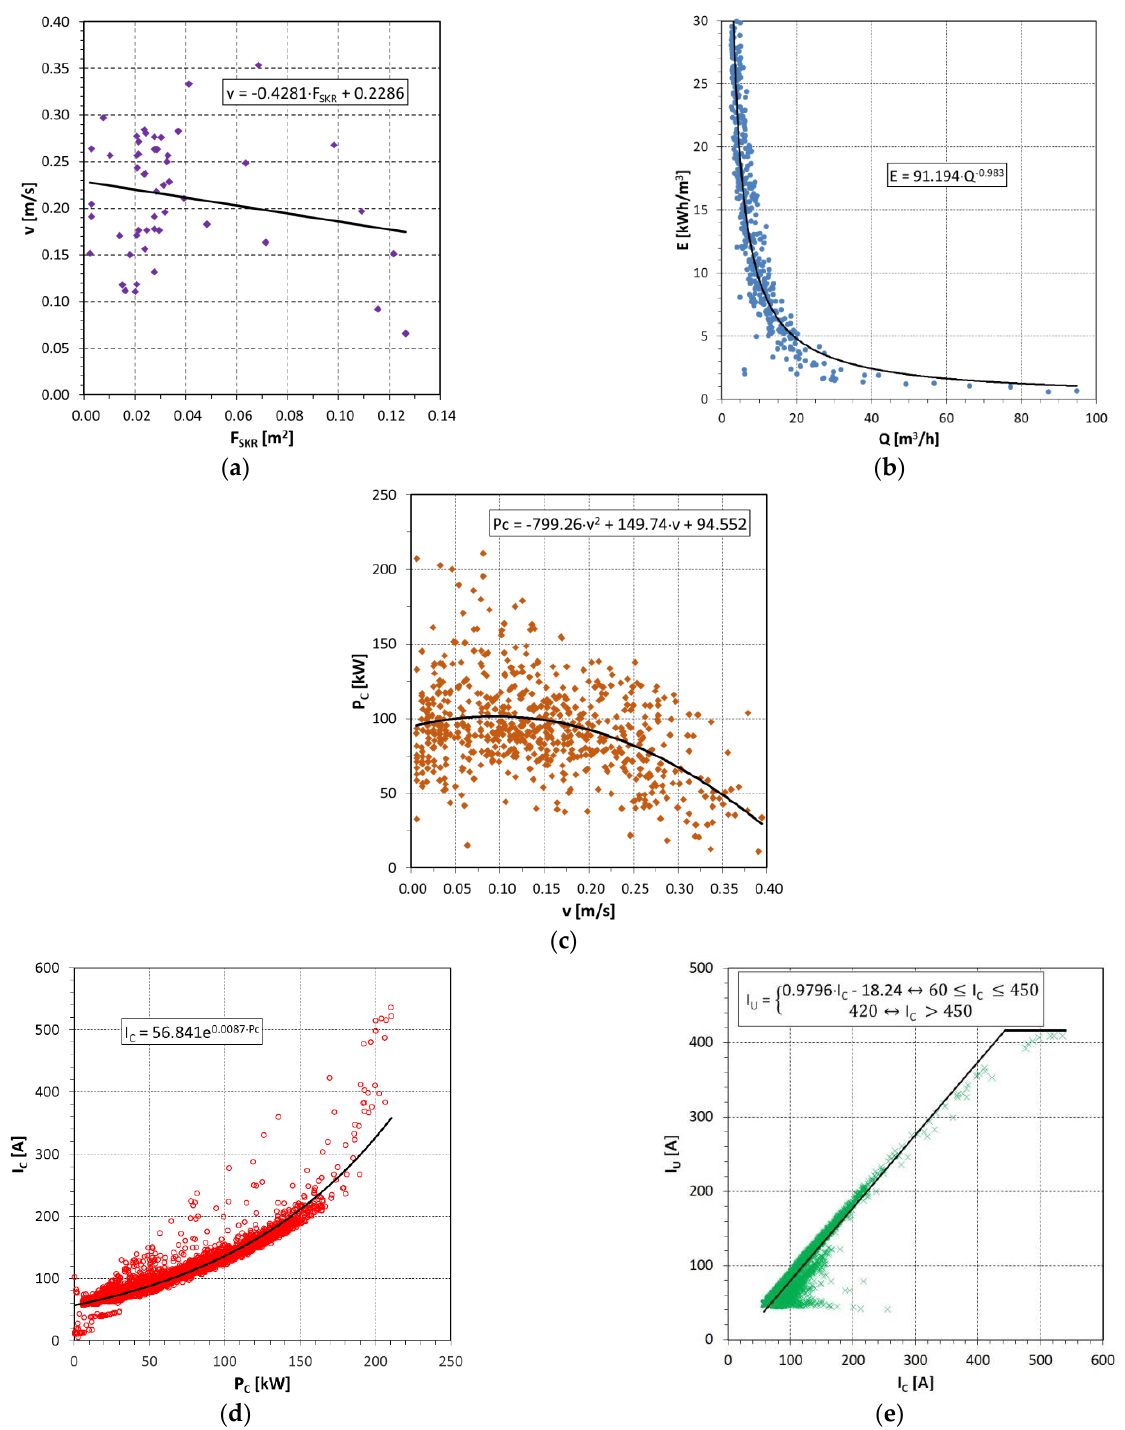
Figure 6. Exemplary actual characteristics of the rock mining process with compressive strength UCS = 50 MPa, recorded during the operation of the R-130 roadheader in operating conditions: ( a ) dependence of the speed of movement of the cutting heads v on the cut ’ s cross-sectional area of F SKR , ( b ) dependence of the mining energy consumption E on the efficiency Q , ( c ) dependence of the power consumed by the roadheader P C on the speed of movement of the cutting heads v , ( d ) dependence of the roadheader supply current I C on the power consumed P C , ( e ) dependence of the motor supply current in the drive of the cutting heads I U on the roadheader supply current I C